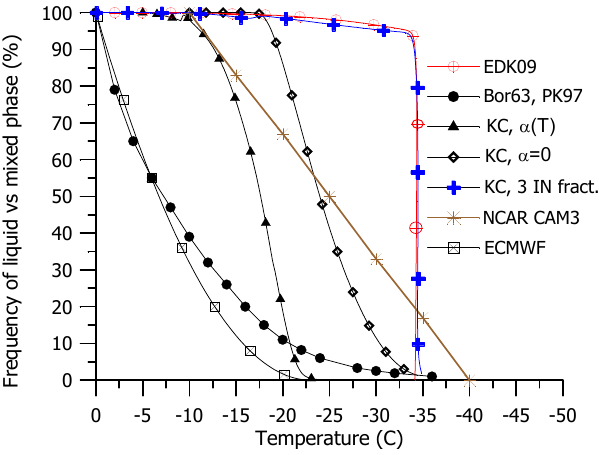
Fig. 3. Frequency of liquid vs mixed states. Climatological data after Borovikov et al. (1963) (see also Fig. 2-33 in PK97), compared to the characteristic of the liquid/mixed phase, the ratio f l = LWC/(LWC+IWC), simulated with the KC05-CK10 parcel model and heterogeneous KC ice scheme in the same 3 simulations shown in Fig. 2: #1) only 2nd aerosol mode included as in EDK09, N d 2 = 1 cm -3 (1000 L -1 ), σ d 2 = 2, r d 2 = 0.4 µ m, and active site area α = 0 (diamonds); #2) only the same 2nd aerosol mode and α ( T ) as described in the text (triangles); #3) 3 IN fractions included with 3 values of contact parameter, 0.85, 0.75 and 0.5, and concentrations 10, 10 and 10 L -1 (blue crosses). These results are compared to EDK09 parcel model simulations with PDA08 ice scheme, the same aerosol and α = 0 (open red circles), and to the corresponding T -partitioning of the liquid and ice phases in the climate models with single-moment microphysics: the NCAR CAM3 (Boville et al., 2006), (83 % liquid at –15 ° C) and ECMWF (ECMWF-2007), (12 % liquid at –15 ° C) as described in the text.